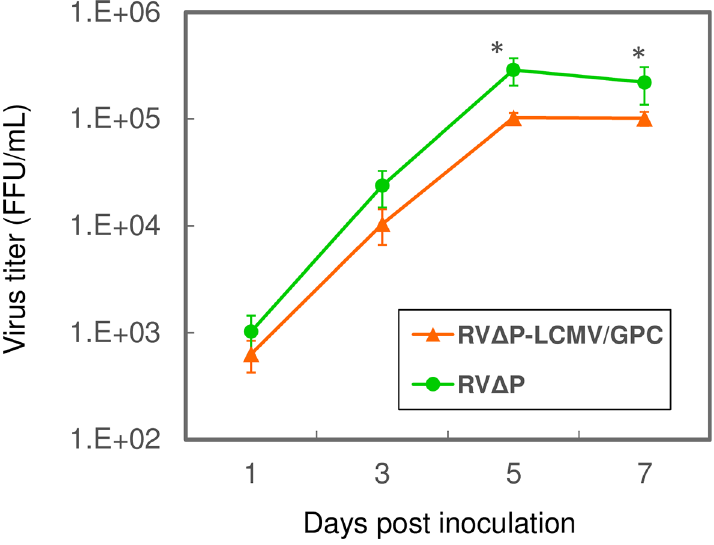
Fig 3. Growth kinetics of RV Δ P-LCMV/GPC and RV Δ P in BHK-P cells. BHK-P cells were inoculated with RV Δ P-LCMV/GPC or RV Δ P at an MOI of 0.01. Culture supernatants were harvested at 1, 3, 5, and 7 days post inoculation, and virus titers were determined using BHK-P cells. The data were expressed as mean ± SE of 4 independent experiments. Asterisks indicate a significant difference (p <